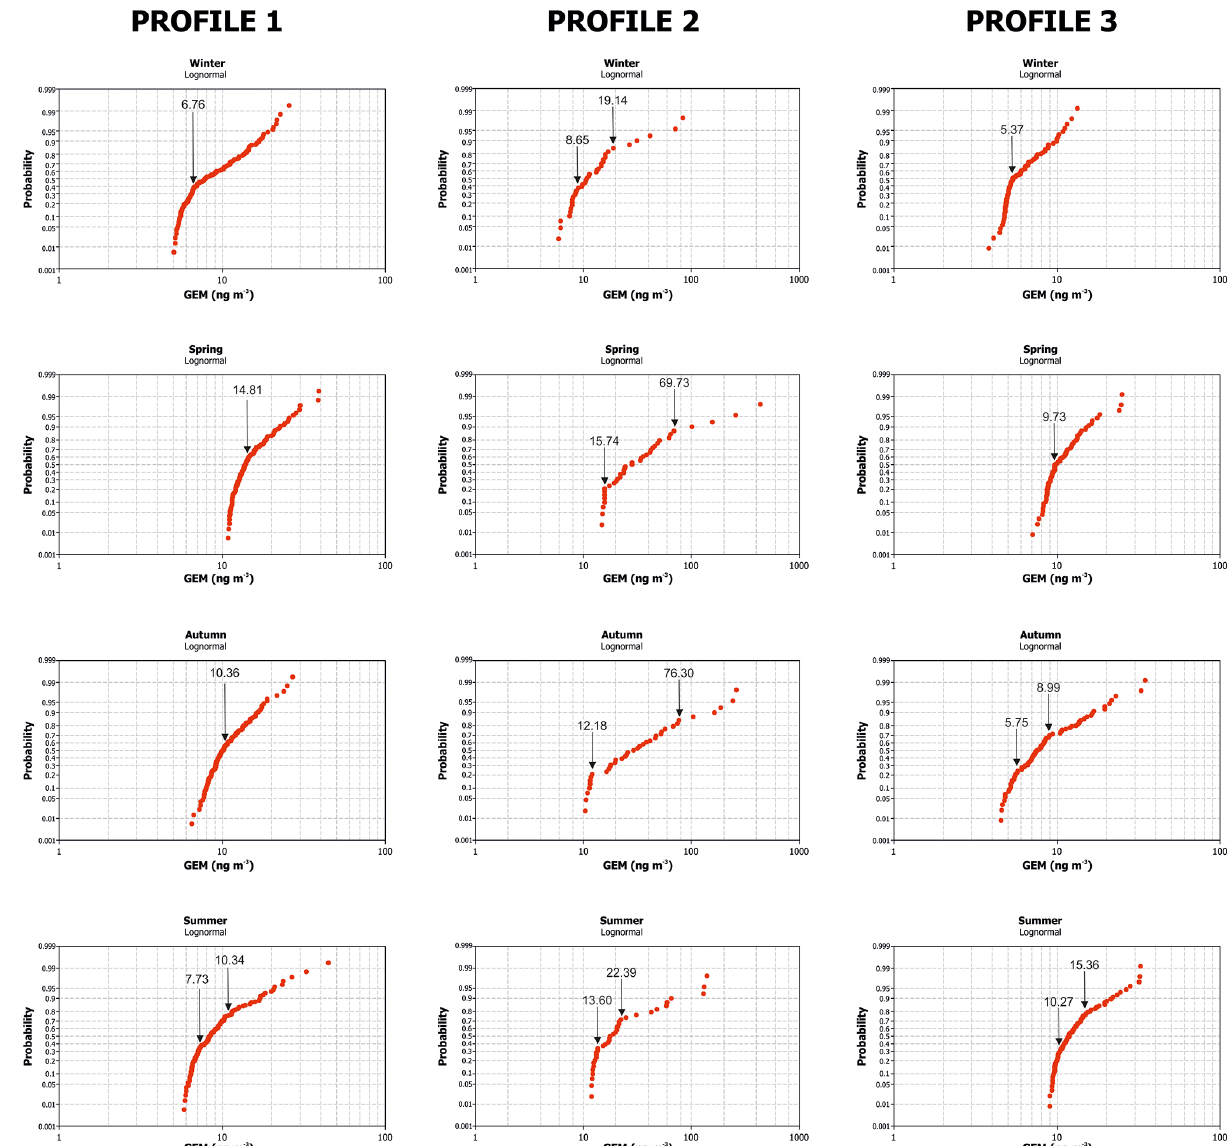
Figure 7. Lepeltier graphs for each profile according to the